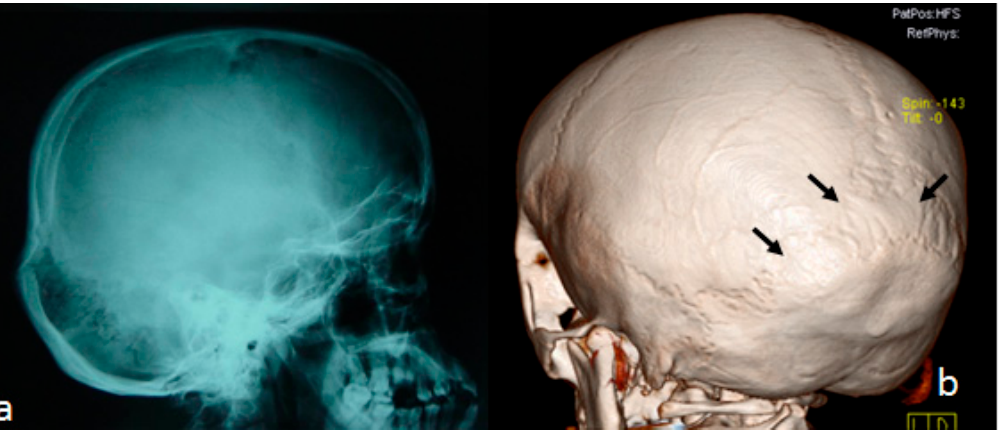
Figure 4. ( a , b ) Lateral skull radiograph showing an 8-year-old girl with multicentric carpotarsal osteolysis syndrome showing multiple wormian bones in the lambdoid sutures and prominence of the occipital bone associated with progressive thinning protuberance of the squamous part. The soft bones of the skull base might allow for progressive infolding of the dysplastic clivus and translocation of the odontoid into the posterior fossa. Combination with platybasia is a predisposing factor for basilar impression and can lead to severe distortion of the spinal cord and the anterior brain stem ( a ). Three-dimensional reconstruction CT scan of the lambdoid sutures showing downward redundancy of the lambdoid sutures in a pattern similar to a stretched pastry, which was interpreted via radiology as wormian bones. Note the stretched-pastry-like phenotype (arrows) ( b ).